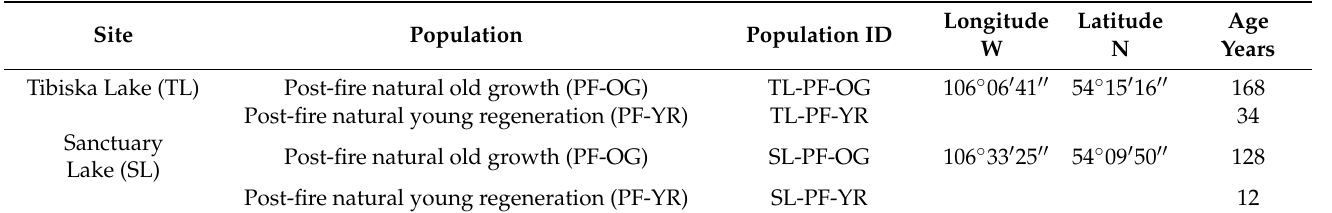
Table 1. White spruce populations studied and their geographical coordinates and age at sampling.